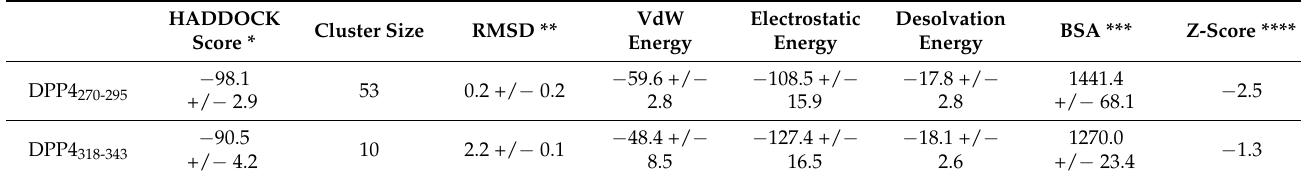
Figure 3. Key contacting elements inside ( a-b ) the RBD-up/DPP4 270–295 conformation, and ( c-d ) the RBD-up/DPP4 318–343 . Panels ( a ) and ( c ) show in stick representation all side chains involved in H-